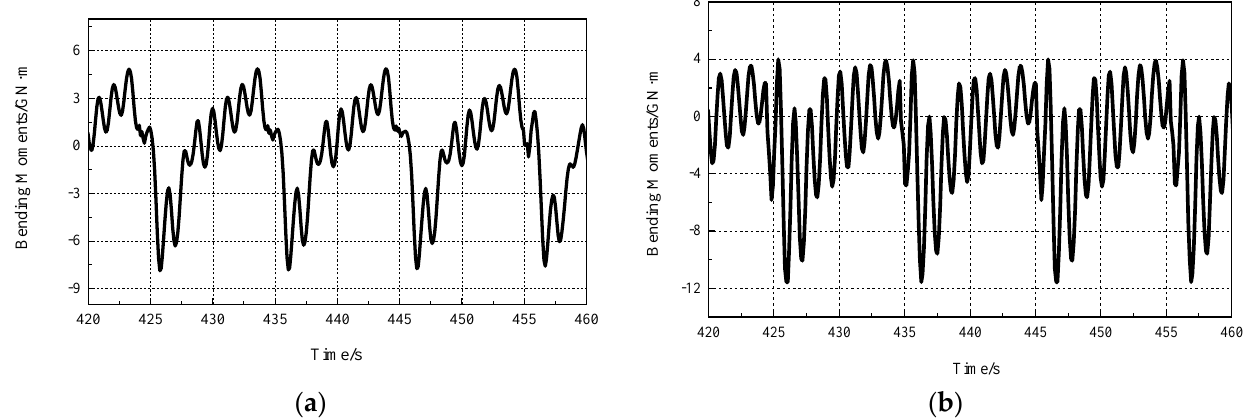
Figure 10. Time histories of bending moments ( U = 15 kn). ( a ) Without slamming effect; ( b ) With slamming effect.